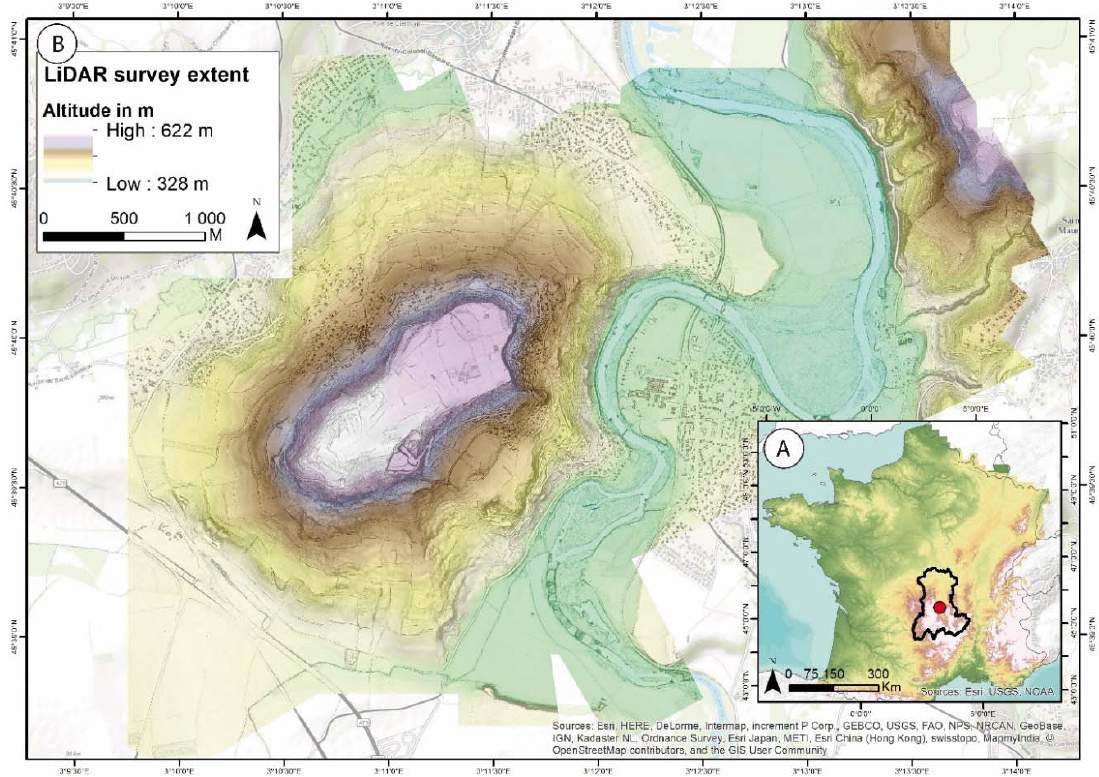
Figure 1. ( A ) Study area location in French Massif Central; ( B ) LiDAR survey extent. The Allier River alluvial plain and terraces occupy the eastern area, whereas the Corent plateau and its slopes stand in the central and western areas.